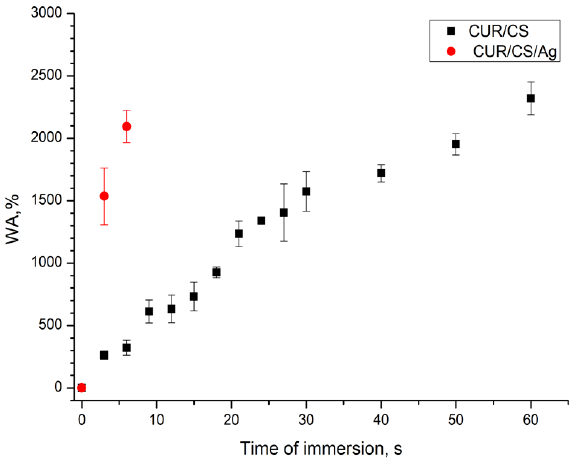
Figure 8. PBS absorption capacity of the CUR/CS and CUR/CS/Ag